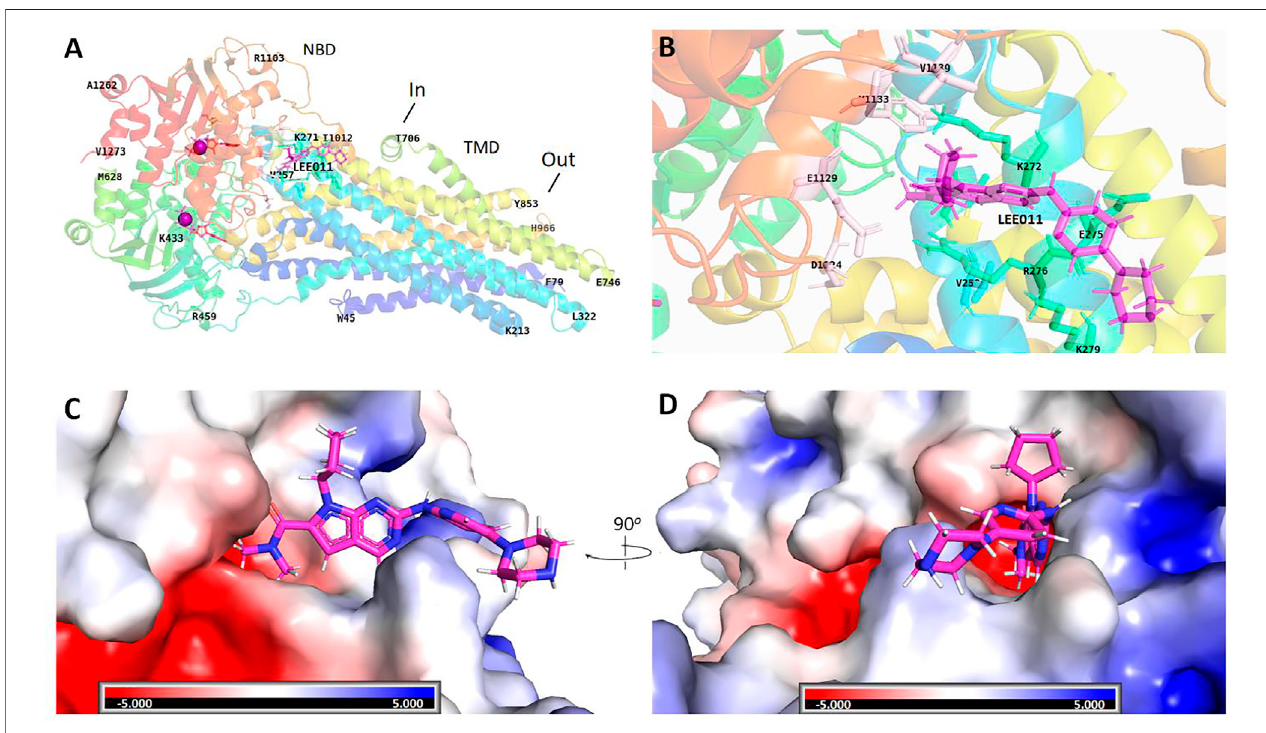
FIGURE 3 | Structural basis for the interaction of ribociclib with P-gp. Docking analysis of the 3-dimentional structure of the ribociclib-P-gp complex were performedusingHEX8.0software. (A) RibociclibinteractedwiththeNBDdomainneartheinterfaceattheinnerside. (B) Themagni fi edregionshowingtheaminogroups that interact with ribociclib (C, D) Spatial structure and charge distributions of the site that binds